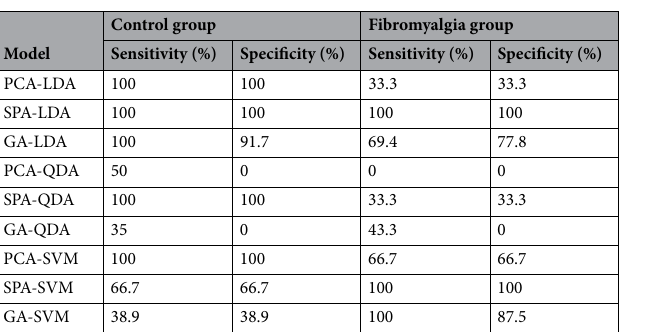
Table 1. Sensitivity and specificity results, in percentage, for the control group and with FM, demonstrating the effectiveness in classifying the groups using the supervised models.